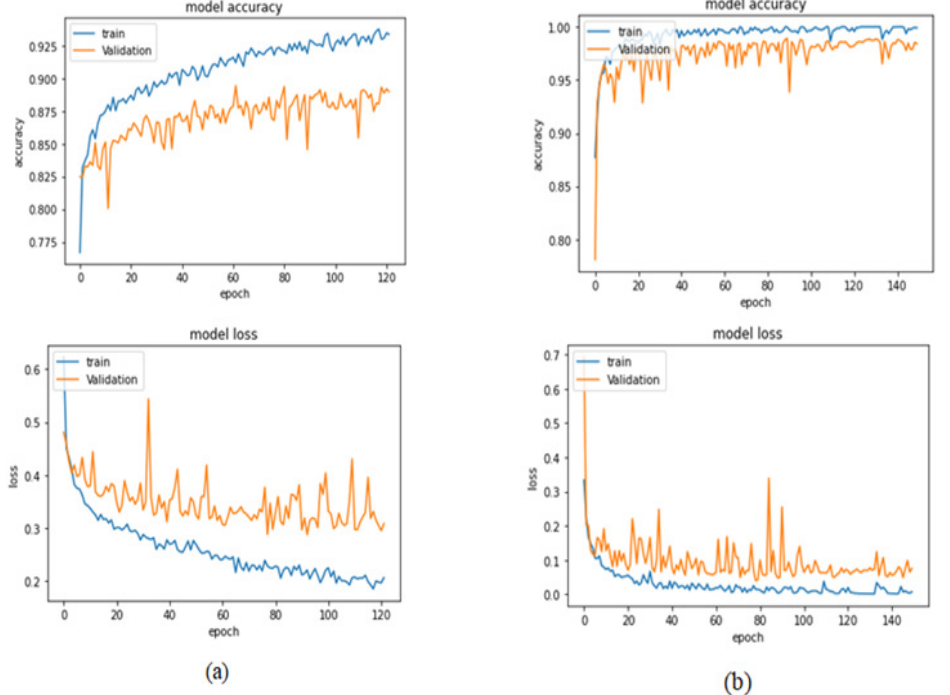
Figure 11. Learning curves for the best obtained results in magnification-independent binary classification, which are achieved by Xception model at 0.0001 learning rate. ( a ) Accuracy and loss curves of Phase 1 of training. ( b ) Accuracy and loss curves of Phase 2 of training.